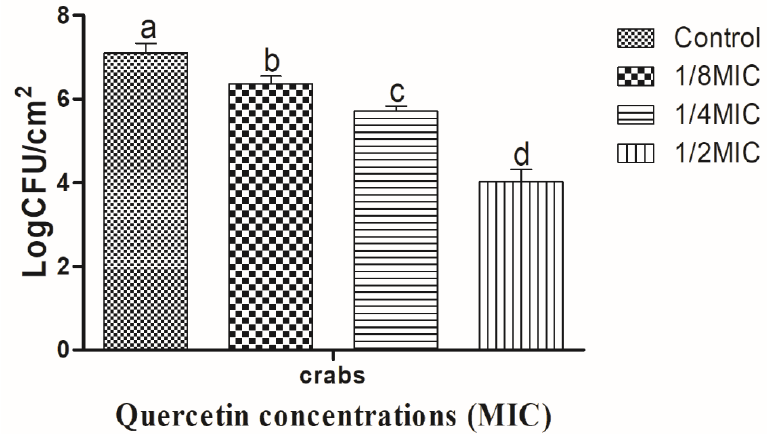
Figure 4. Inhibition of Vibrio parahaemolyticus biofilm formation (24 h) on crab surfaces by sub-MICs of quercetin (µg/mL). Data represented as mean ± SEM of three independent replicates. a–d Values with different letters differ significantly by Duncan’s multiple-range test ( p < 0.05).